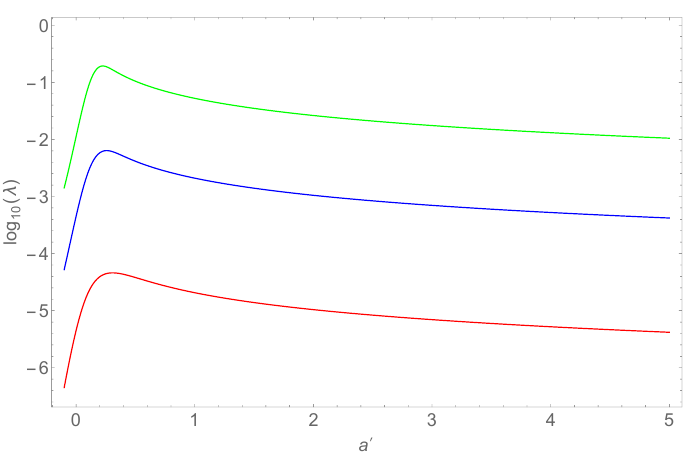
Figure 3 . log( λ ) vs a 0 for ξ = 100 , 1000 and 5000 . Colors are labeled as in figure